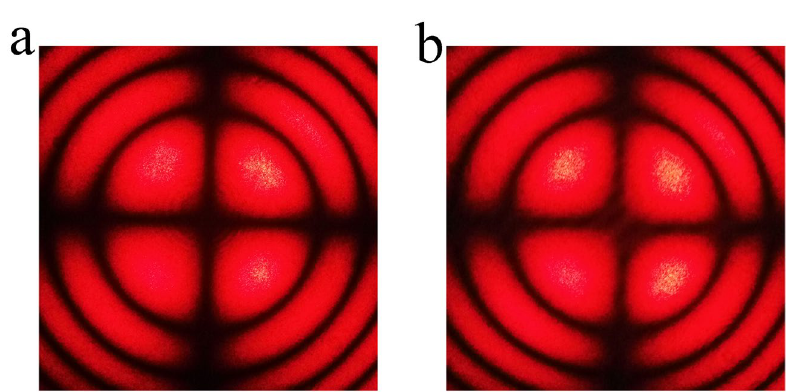
Figure 4. Conoscopic interference patterns for the two crystals. ( a ) z-cut LN crystal. ( b ) (xztw)-1.2°/1.2°-cut LN